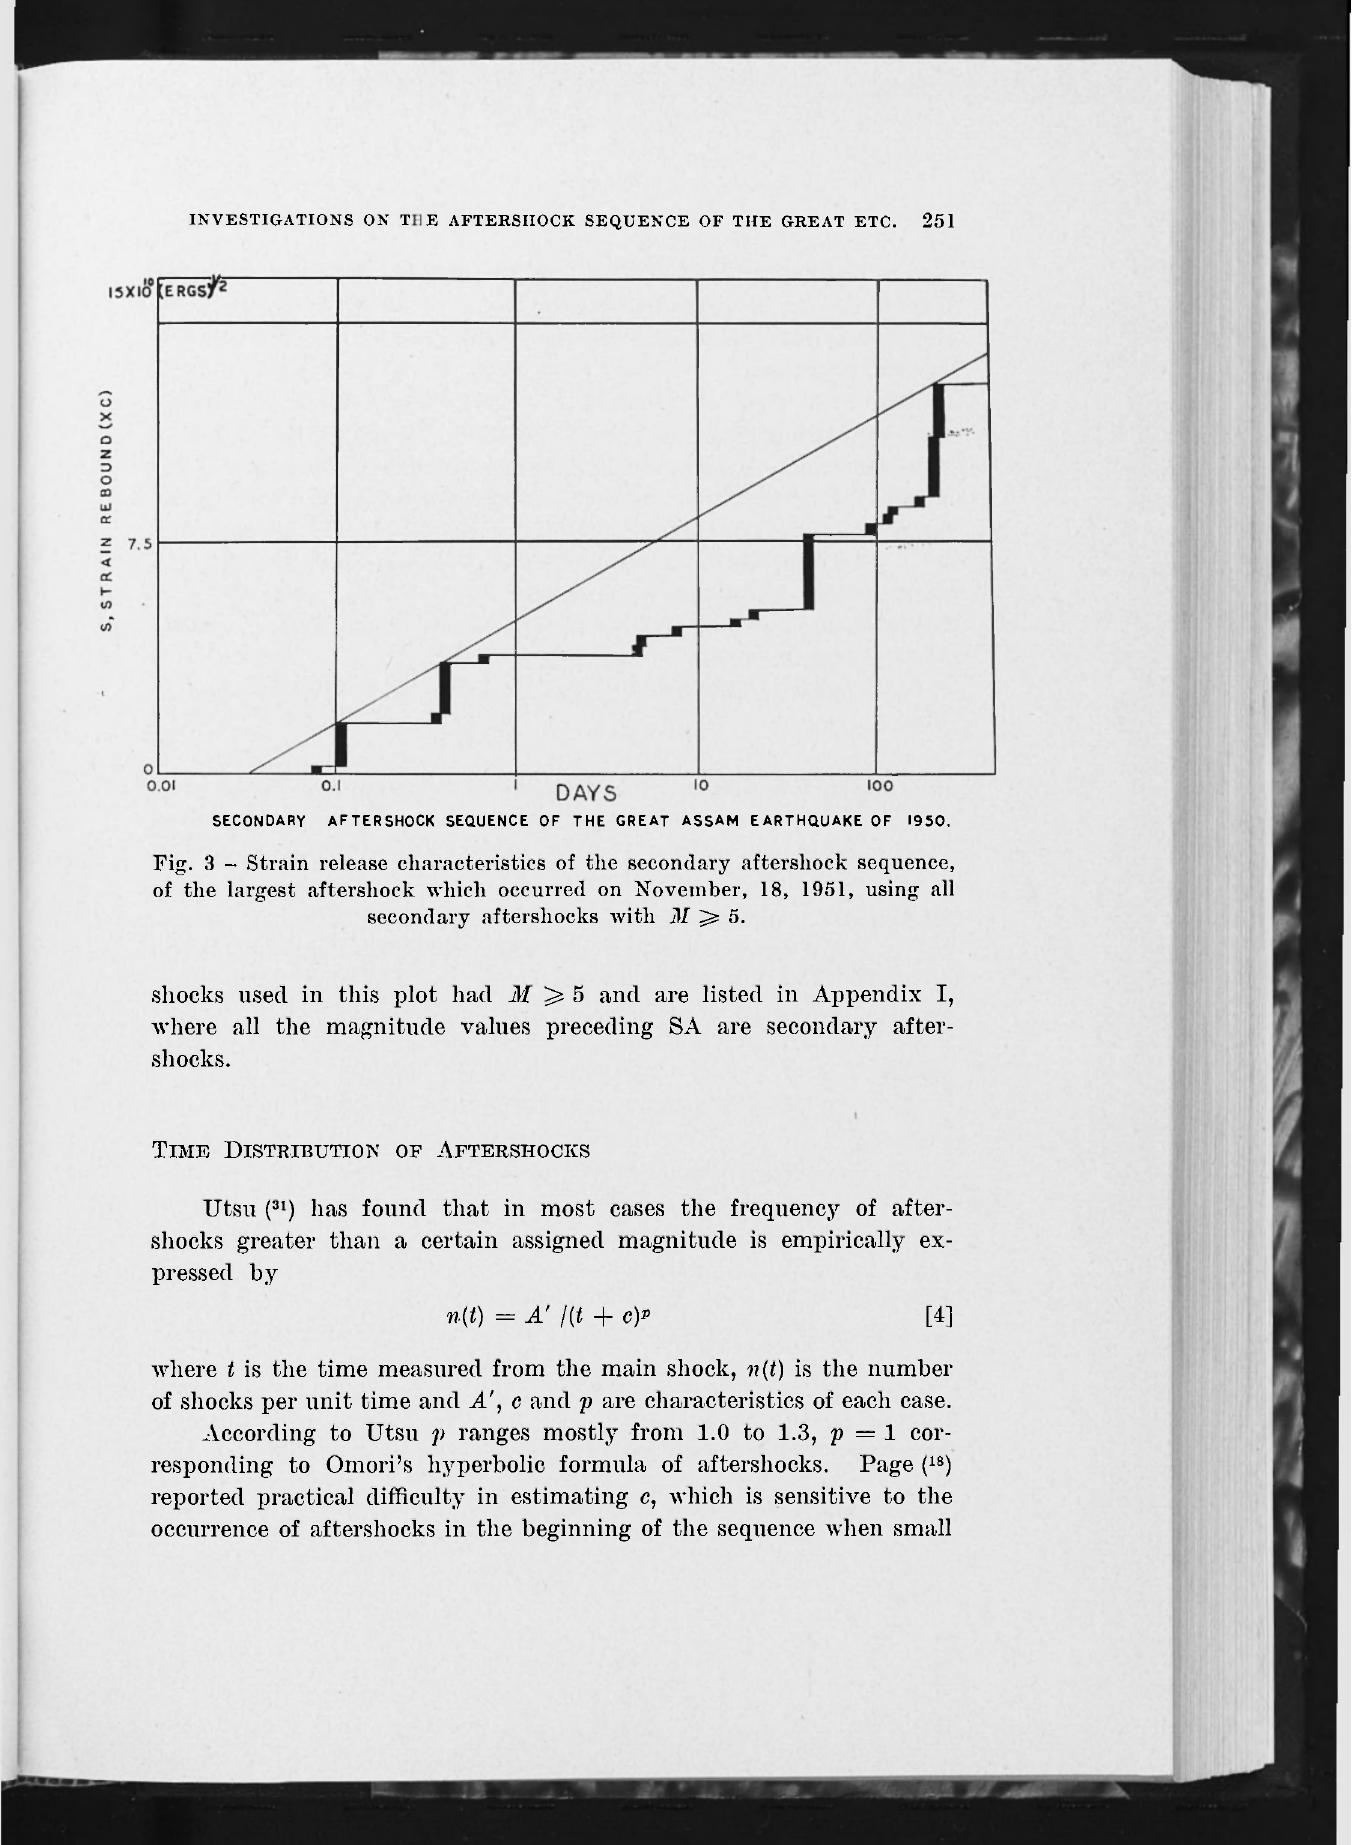
AFTERSHOCK SEQUENCE OF THE GREAT ASSAM EARTHQUAKE OF 1950. Fig. 3 - Strain release characteristics of the secondary aftershock sequence, of the largest aftershock which occurred on November, 18, 1951, using all secondary aftershocks with 31 ^